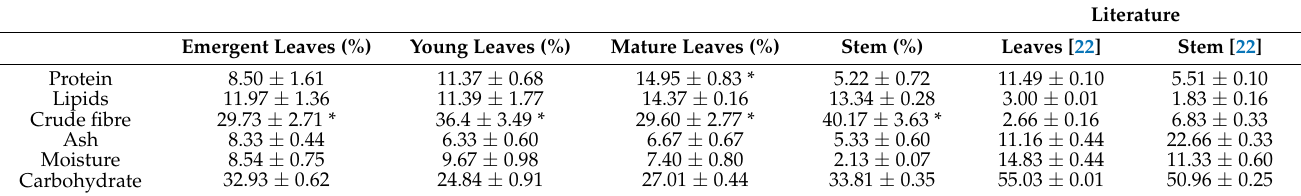
Table 1. Yield of extracts of D. villosa leaves, stem bark and nanoparticles. Methanol (%) Chloroform (%) Hexane (%) Leaves 10.8 8.4 Stem bark Table 2. Nutritional content (%) of investigated D. villosa leaves and stem bark.